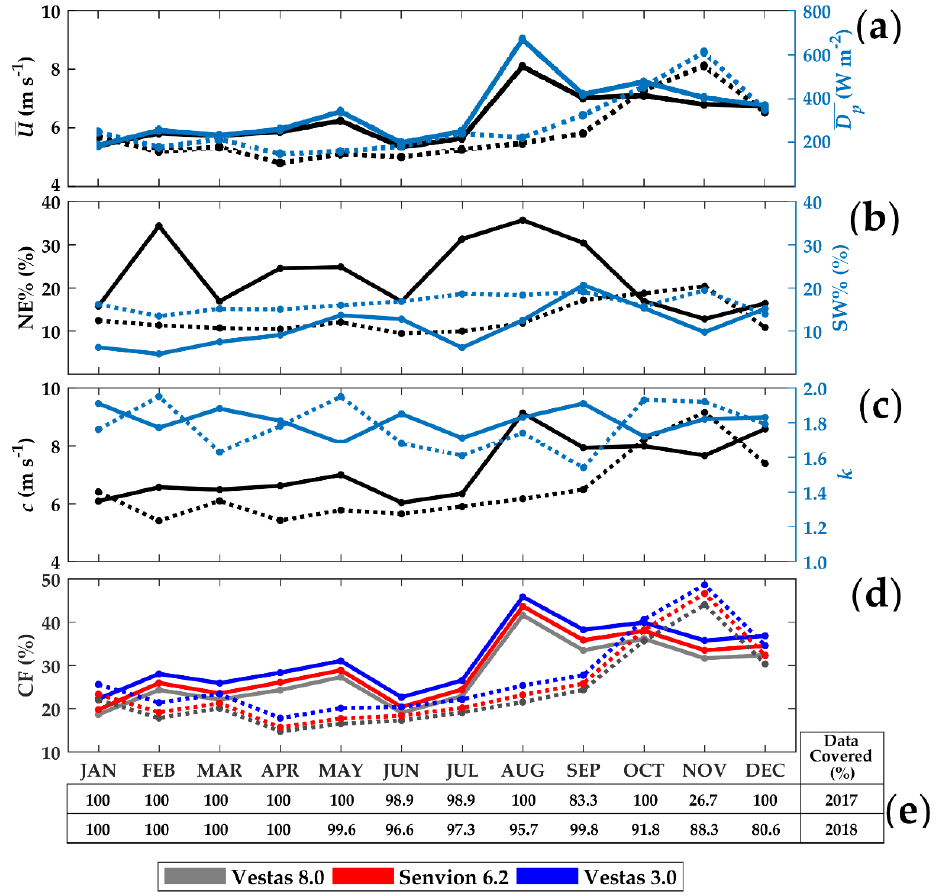
Figure 7. Monthly variation of wind resources, Weibull distribution parameters, and production of turbines for 2017 (solid lines) and 2018 (dotted lines) based on the 10 min LIDAR time series at 110 m high. ( a ) Mean wind speed U ̅ (m s −1 ) (left axis, black line), and mean power density D p ̅̅̅̅ (W m −2 ), (right axis, blue line). ( b ) NE% (black line) and SW% (blue line) percentages of northeasterly (45° ± 15°) and southwesterly (−135°± 15°) winds, respectively. ( c ) The Weibull scale parameter c (m s −1 ) (black) and Weibull shape parameter k (blue). ( d ) Capacity factor CF (%) of the three turbines: Vestas 8.0 (gray), Senvion 6.2 (red), and Vestas 3.0 (blue). ( e ) LIDAR monthly data coverage for 2017 and 2018.